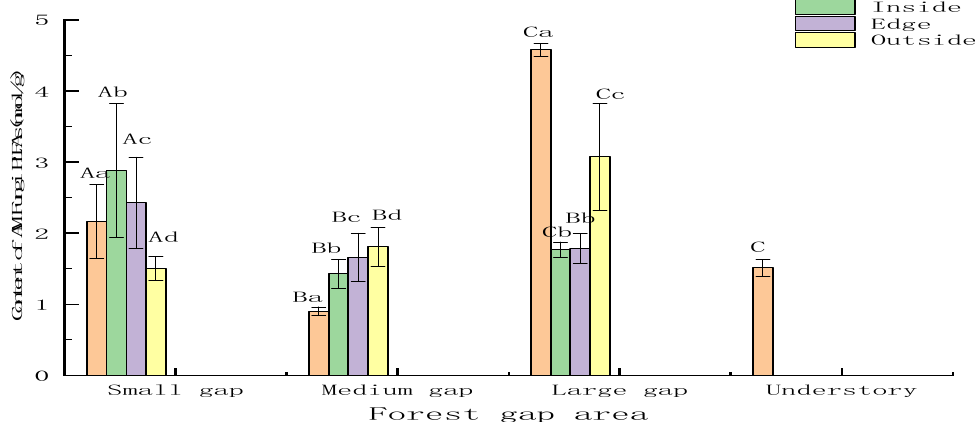
Figure 6. Contents of AM Fungi PLFAs in the different forest gap area (mean ± SE, 95% CI). Note: A, B, C, and D indicate differences in the same gap position with different sizes; a, b, c, and d show differences in a different position within the same gap ( p < 0.05).